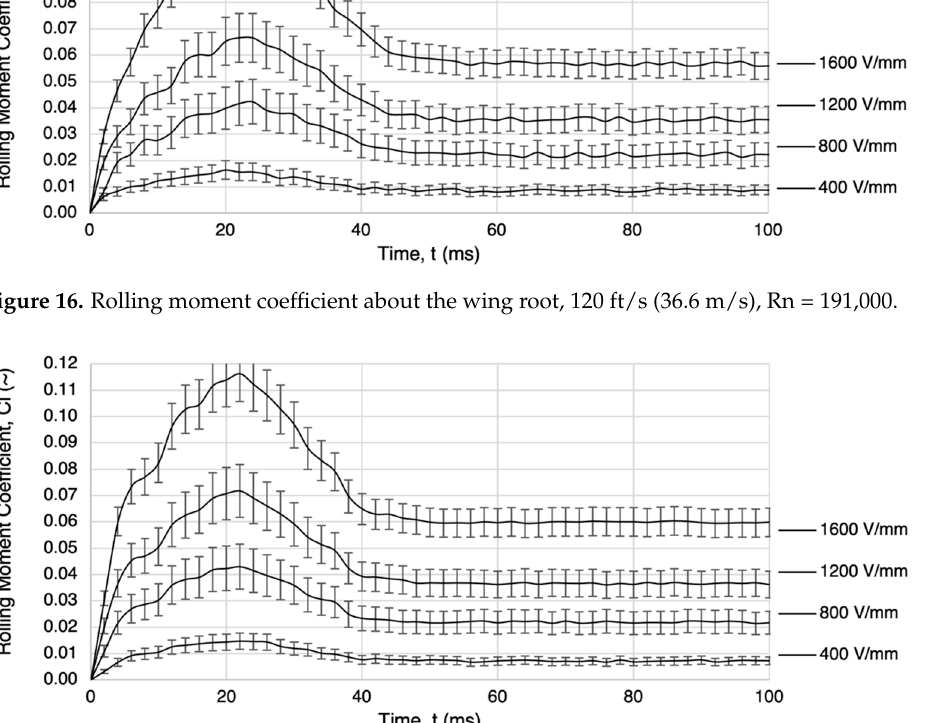
Figure 17. Rolling moment coefficient about the wing root, 160 ft/s (48.8m/s), Rn = 255,000.